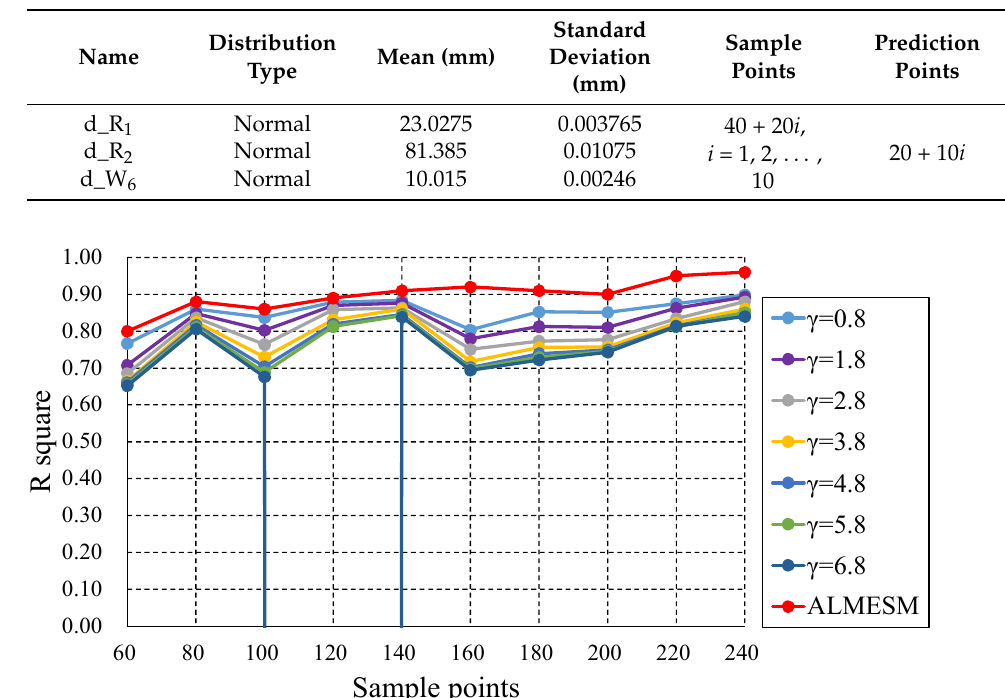
Table 4. The material properties of GH720Li at 650 °C and the boundary conditions.